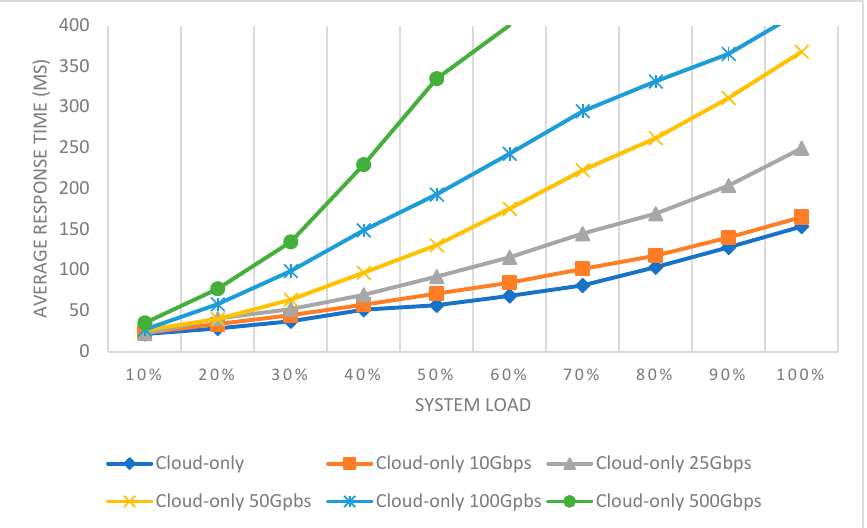
Figure 9. Detection average response time with a variant uplink bandwidth.